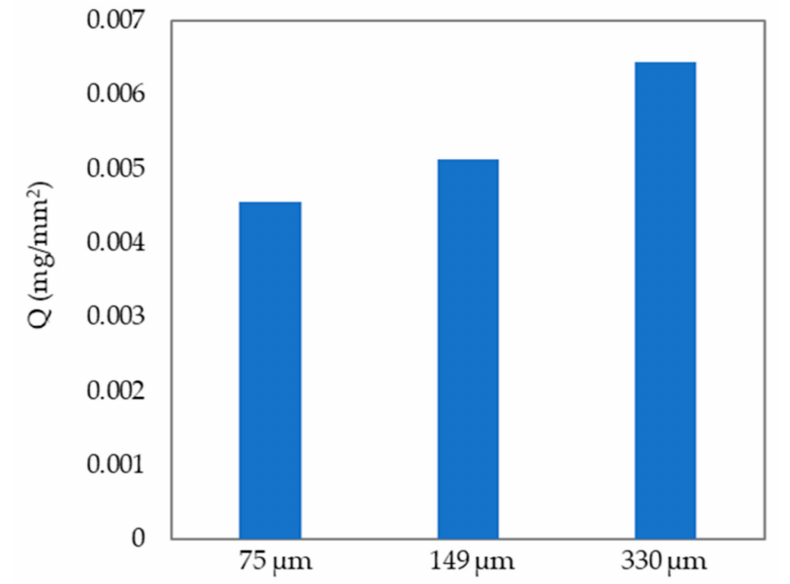
Figure 11. The amount of material removal per unit area